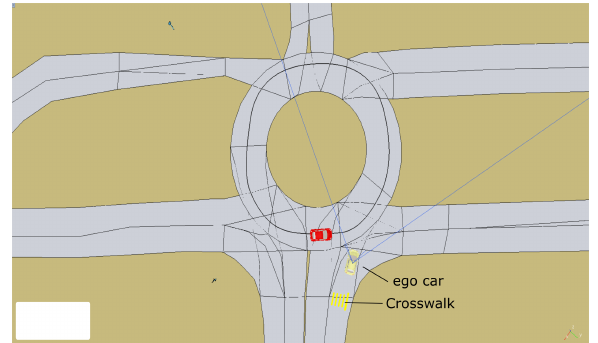
Figure 15. Entering a roundabout scenario. The ego car, in yellow, first encounters a crosswalk and then has to yield to other cars when entering the roundabout.